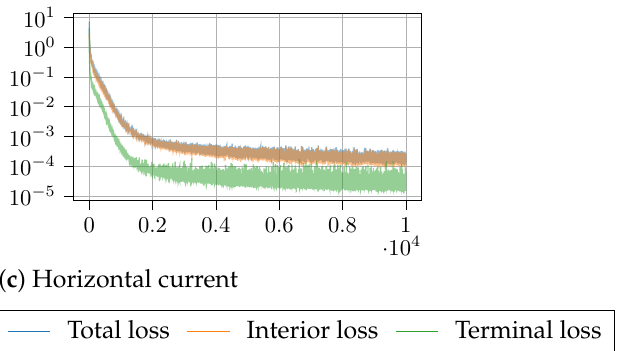
Figure 2. Training losses of DGM for the surrogated OCP solution (13): the horizontal axis represents the training epoch, while the vertical axis represents the losses (lower is better). We represent the total loss, which is the sum of the interior loss (8) and the terminal loss (9): as the latter is around one order of magnitude smaller than the former, the total loss is dominated by the interior loss. Note how all losses are minimized as the training advances, which means that DGM converges to a solution of the HJB equation.